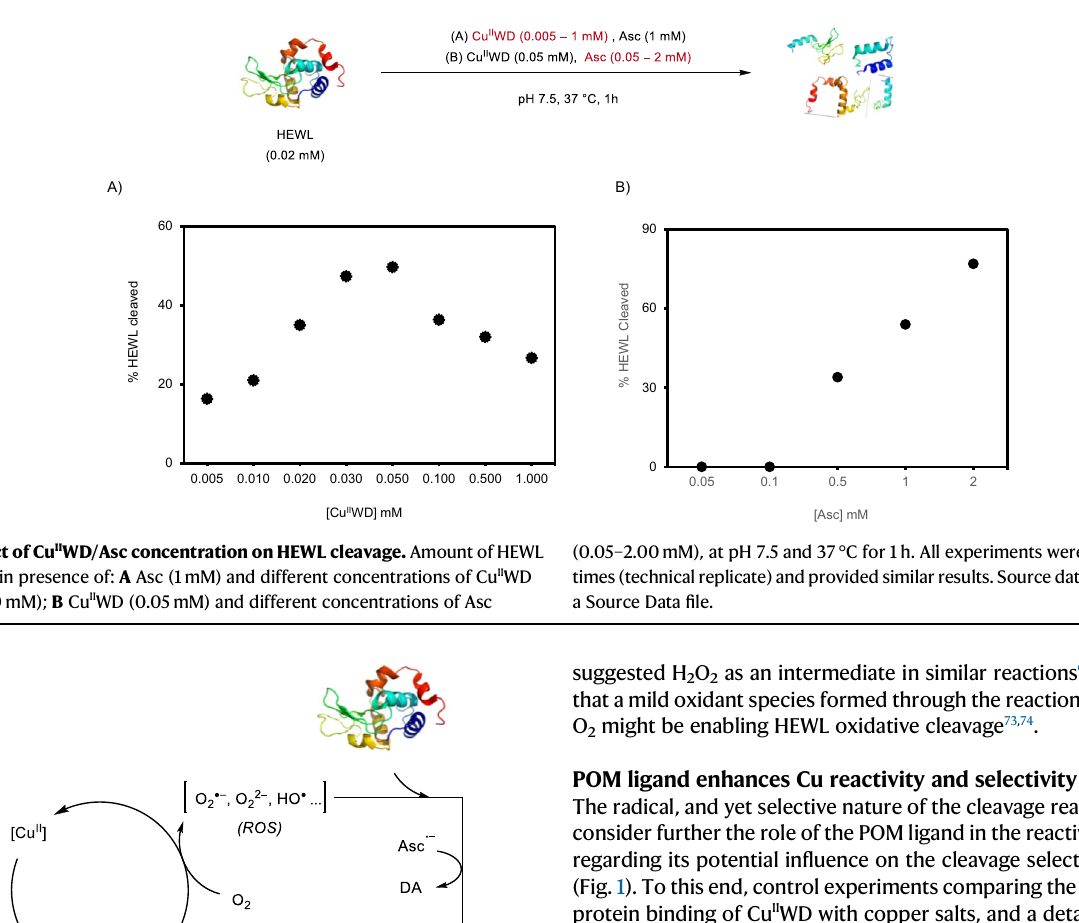
Fig. 3 | Proposed mechanism of the reaction of Cu II with Asc. Reactive oxygen species(ROS)aregeneratedbyCu(I)intermediatereactionwithmolecularoxygen. Cu(I) intermediate is formed by oxidation of ascorbate in situ. DA=dehydroascorbic